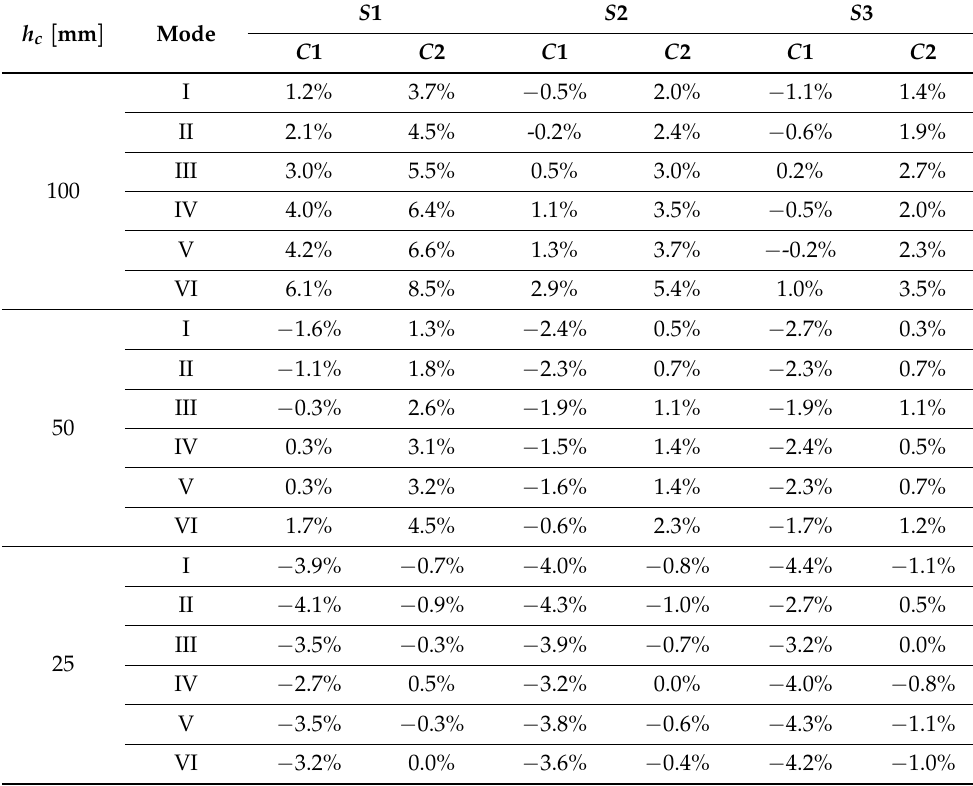
Table 4. The relative errors between averaged models and FEM model for a = 0.020